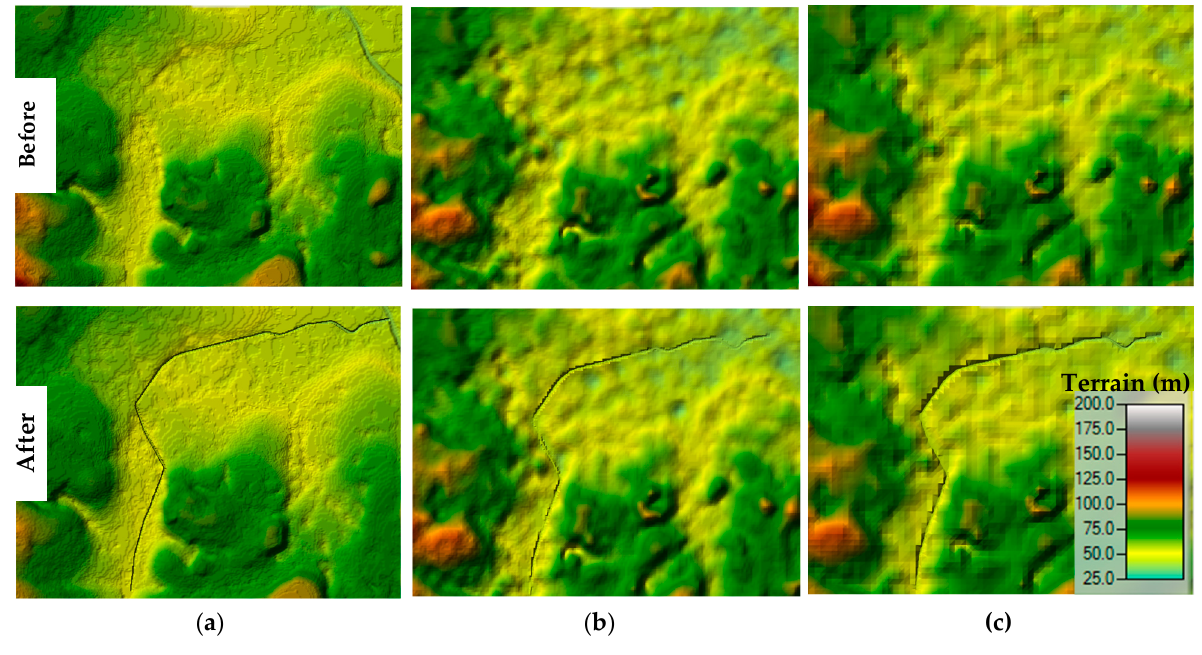
Figure 3. Maps of before and after modification of DEM terrain in Toba Catchment: ( a ) AW3D Standard, ( b ) ALOS PALSAR and ( c ) SRTM.